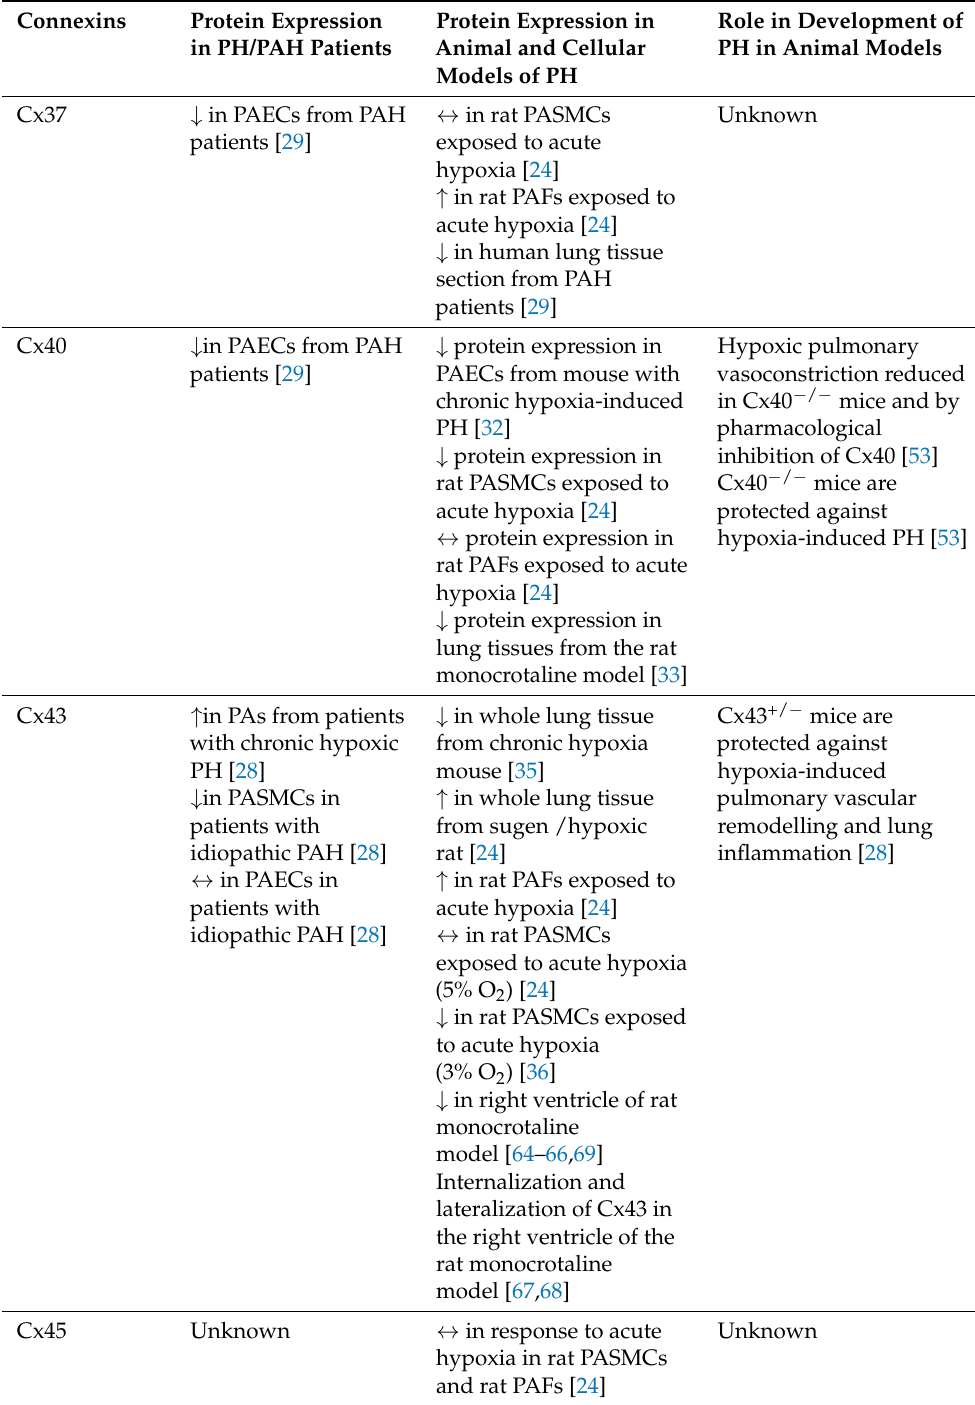
Table 3. Summary of the changes in protein expression of Cx37, Cx40, Cx43 and Cx45 in patients with PH and in animal models of PH. Summary of the role of Cx37, Cx40, Cx43 and Cx45 in the development of PH in animal models. ↔ no change, ↑ increased, ↓